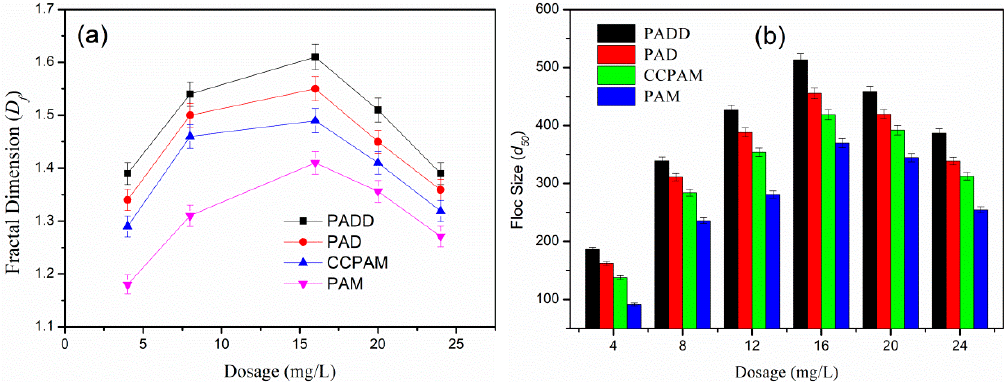
Figure 9. The floc ( a ) fractal dimension and ( b ) floc size.